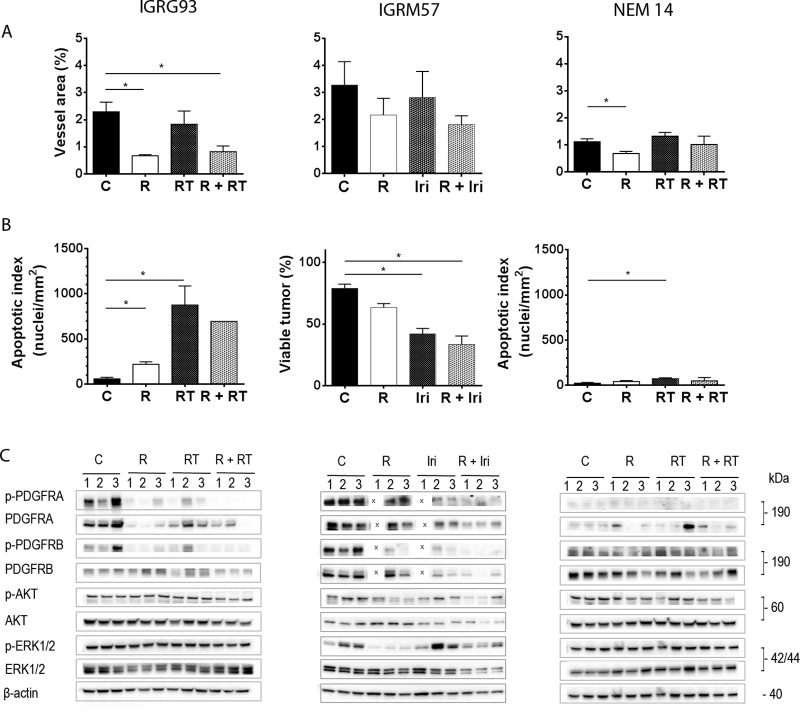
Regorafenib activity alone and in combination against patient-derived tumor models is mediated by anti-angiogenic effects and induction of cell death.Paraffin-embedded sections of IGRG93 (left column), IGRM57 (central column) and NEM14 (right column) tumors, harvested at Day 3 post-treatment initiation, were stained immunohistochemically with anti-CD34 and anti-cleaved caspase 3 antibodies and histologically with Hematoxylin-Eosin-Saffron (HES). (A) Microvessel area and (B) apoptosis index are presented as means ± SEM of 3 controls and regorafenib 30 mg/kg/d treated tumors each (*p<0.05; Mann-Whitney). Due to extensive necrosis only one sample could be evaluated in the combination group of the IGRG93 study. For IGRM57, the assessment of viable tumor by excluding necrotic areas was estimated on HES stained sections. (C) Total lysates from individual tumors were subjected to Western blotting for expression analyses of phosphorylated (p-) and non-phosphorylated PDGFRA, PDGFRB, AKT and ERK1/2. β-actin was used as reference. C: control, R: regorafenib; X: omitted sample due to limited availability of tumor 1; RT: irradiation, Iri: irinotecan.